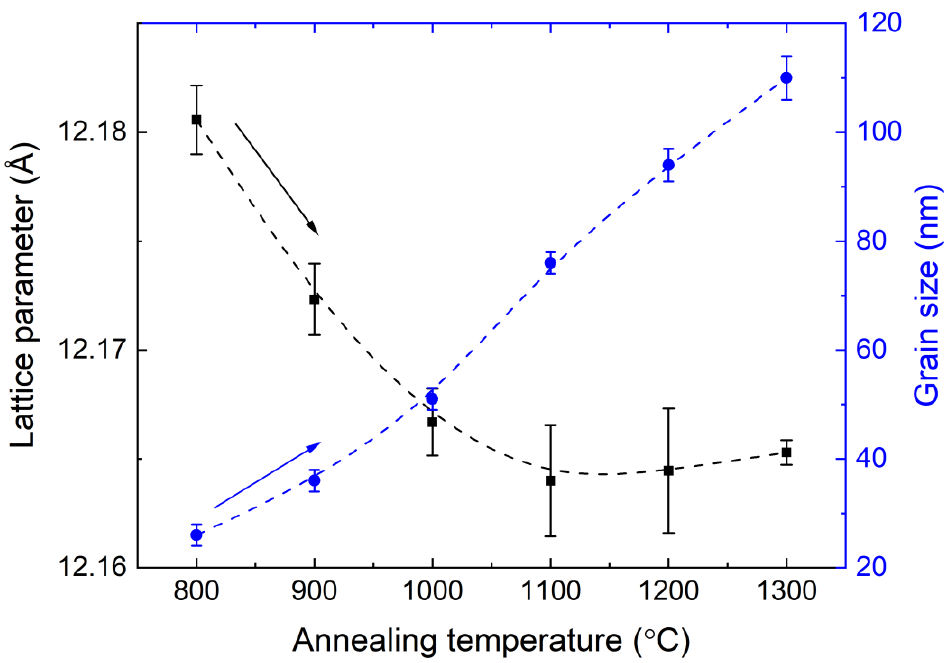
Figure 2. The influence of the annealing temperature on the grain size and lattice parameter of the YAGG nanopowders. YAGG